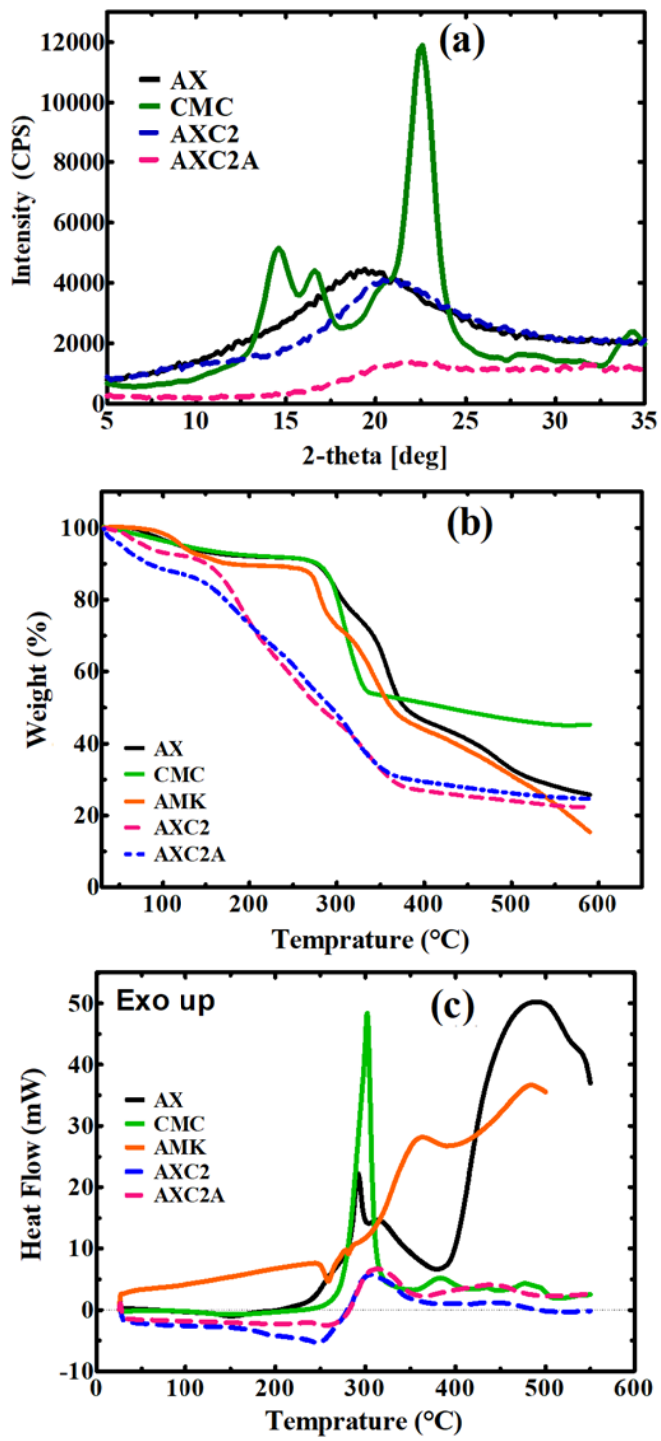
Figure 3. ( a ) XRD, ( b ) TGA and ( c ) DSC analyses of the AX-CMC films. Thermal degradation of pure CMC also occurred in three steps at ambient tempera- ture −125 °C (∆W = 5.06%), 256–335 °C (∆W = 37.2%), and >335 °C (∆W = 9.6%), and these weight losses were attributed to evaporation of moisture, depolymerization, and pyroly-